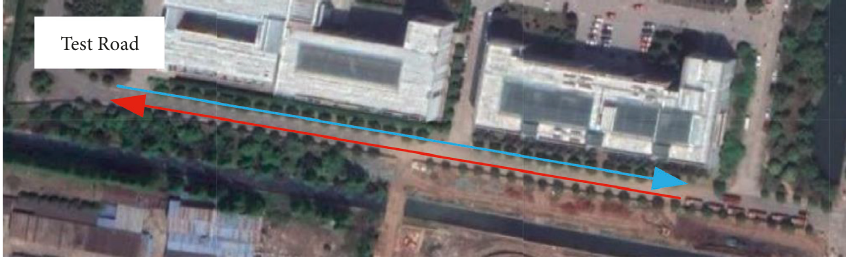
Figure 2: Test road.